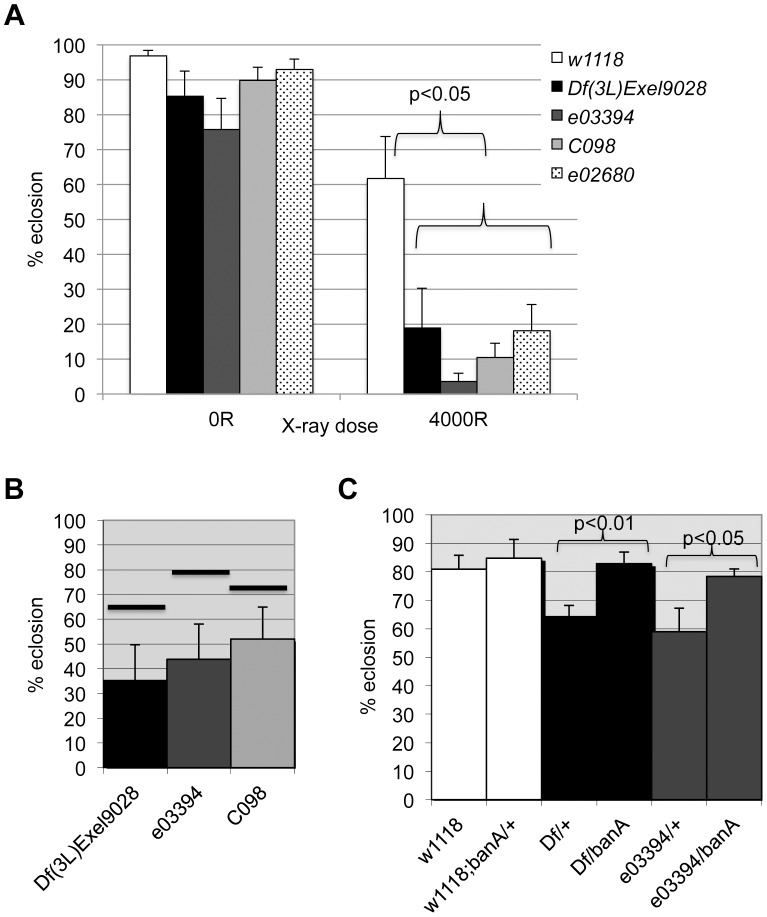

tie interacts with ban to promote radiation survival.Larvae were irradiated at 96±2 h after egg deposition with 4000R of X-rays. Percent eclosion was determined by counting full and empty pupal cases 10 days after irradiation. Error bar  =  1 SEM. (A) Homozygous tie mutants were more radiation sensitive than w1118 controls (p<0.05). N = 106 to 494 pupae per genotype in at least three independent experiments. tie alleles were Df(3L)Exel9028 and transponson insertion alleles in Fig. S5: tiee03394 or ‘03394’, tiec098 or ‘co98’ and tiee02680 or ‘e02680’. (B) tie and ban showed genetic interaction in radiation survival. The observed eclosion of double heterozygotes (tie/ban1170) is shown for each allele of tie. The % eclosion expected from an additive effect between ban1170/+ and tie/+ was computed from observed % eclosion for each allele and shown as solid horizontal bars above each tie allele. In all cases, the observed eclosion was lower than the expected. The difference between expected and observed were significantly different for the three tie alleles shown (X2 test, p<0.05). N = 94–536 pupae in at least three independent experiments per genotype. (C) A UAS-ban transgene ‘banA’ rescued the radiation sensitivity of Df(3L)Exel9028 (‘Df’) and tiee03394 heterozygotes. N = 359–634 pupae in at least six experiments per genotype.